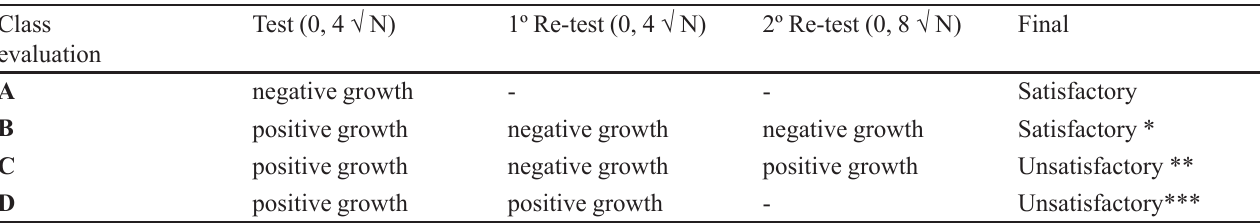
TABLE V - Interpretation of sterility test data according to rule nº 176 Class